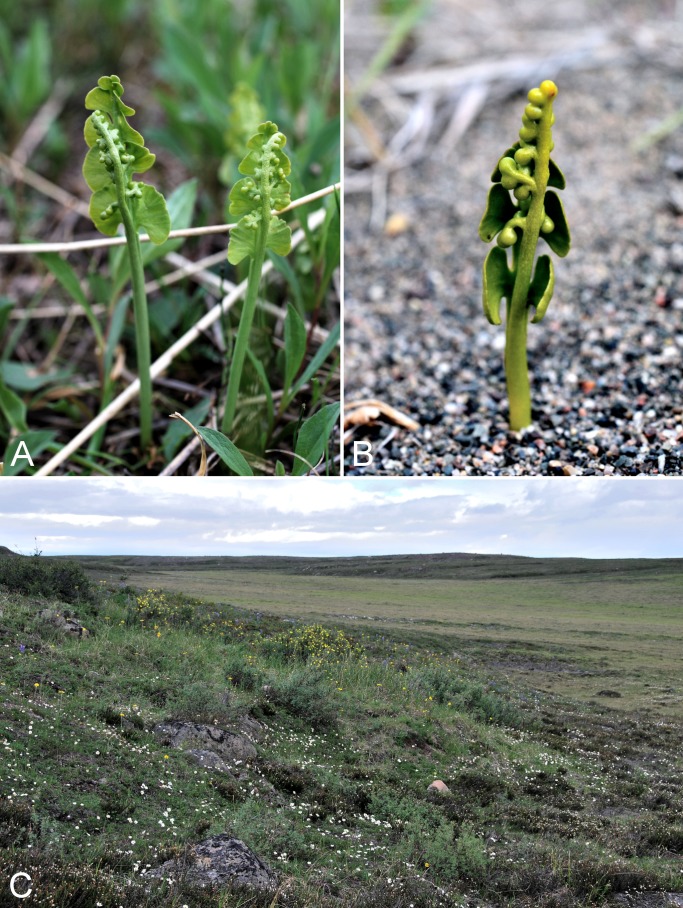
Botrychium tunux.(A) Sporophore, Saarela et al. 3755a. (B) Sporophore, Saarela et al. 4179b. (C) Habitat, Coppermine Mountains, northwest of Coppermine River, Nunavut, 9 July 2014. Photographs by J. M. Saarela (A, C) and P. C. Sokoloff (B).